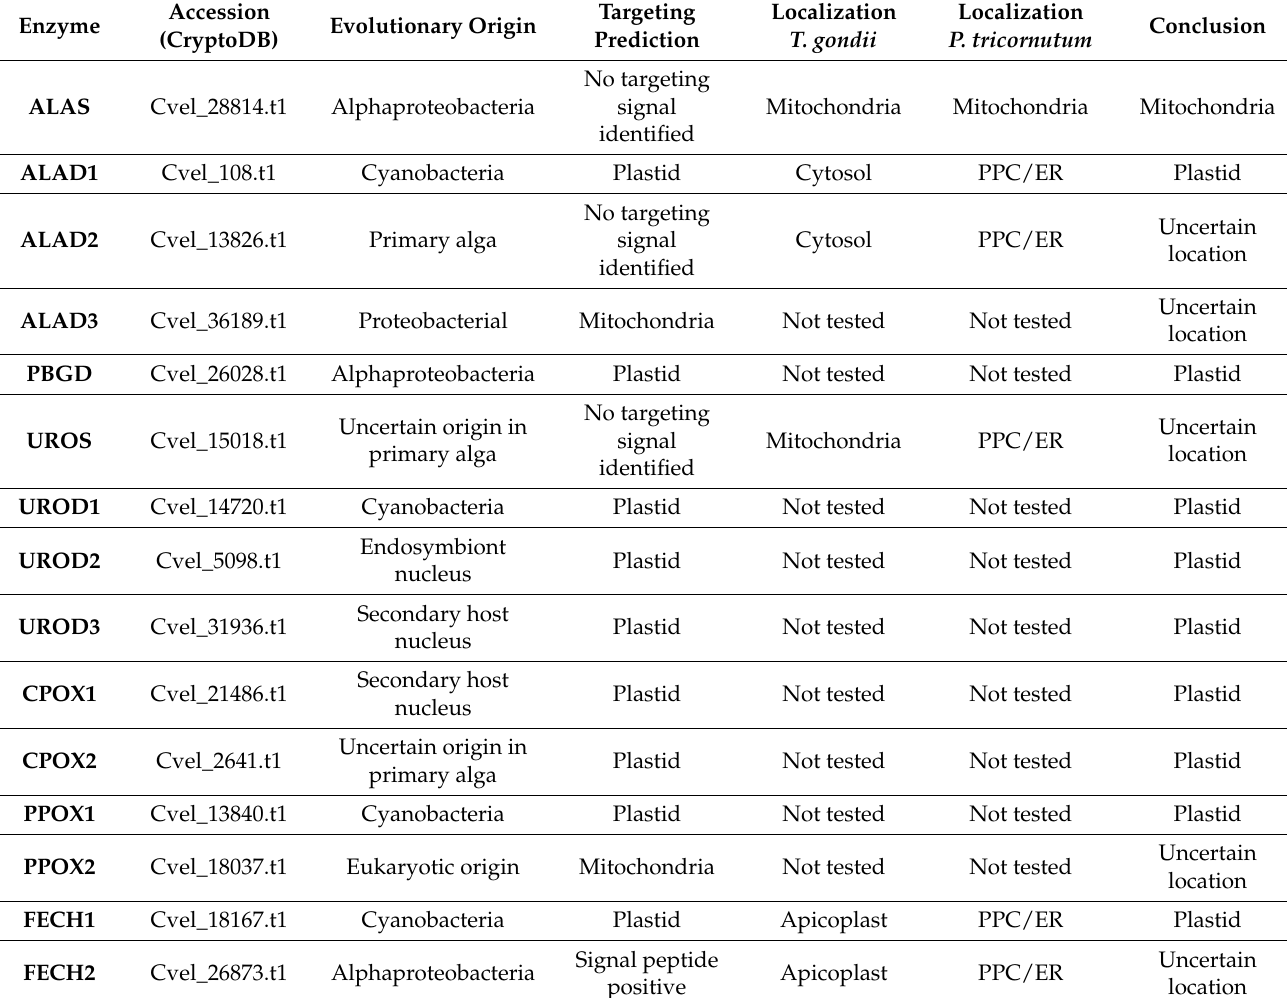
Table 1. Table showing results described in this manuscript. Enzymes are listed according to their order during the synthesis of heme. Evolutionary origins of each of the enzymes are based on phylogenetic analyses from the work of [11,16]. The last column of the table contains our hypothetical conclusions about the C. velia enzyme localization based on our